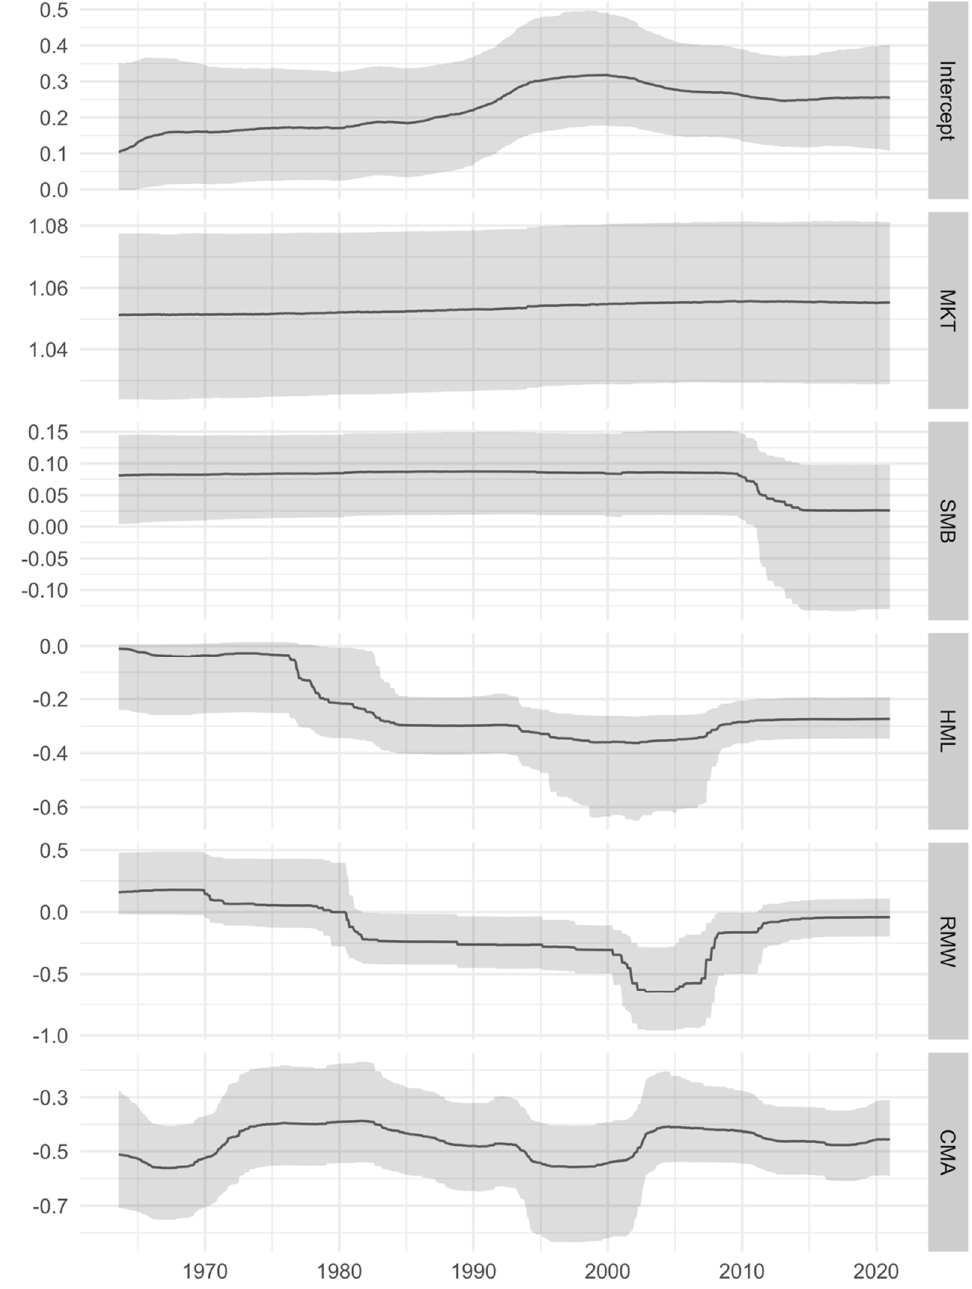
Figure 5. Threshold time-varying parameter beta estimates—High Tech. Note: The figure presents the plots for the posterior medians (solid line) with 68% confidence bands (gray shaded region) of the time varying beta estimates from the TTVP model with stochastic volatility. Gibbs sampling is used with 10,000 posterior and 10,000 burn-in draws. MKT, SMB, HML, RMW and CMA represent the Market, Size, Book-to-Market, Profitability and Investment factors based on the five-factor specification of Fama and French [57].